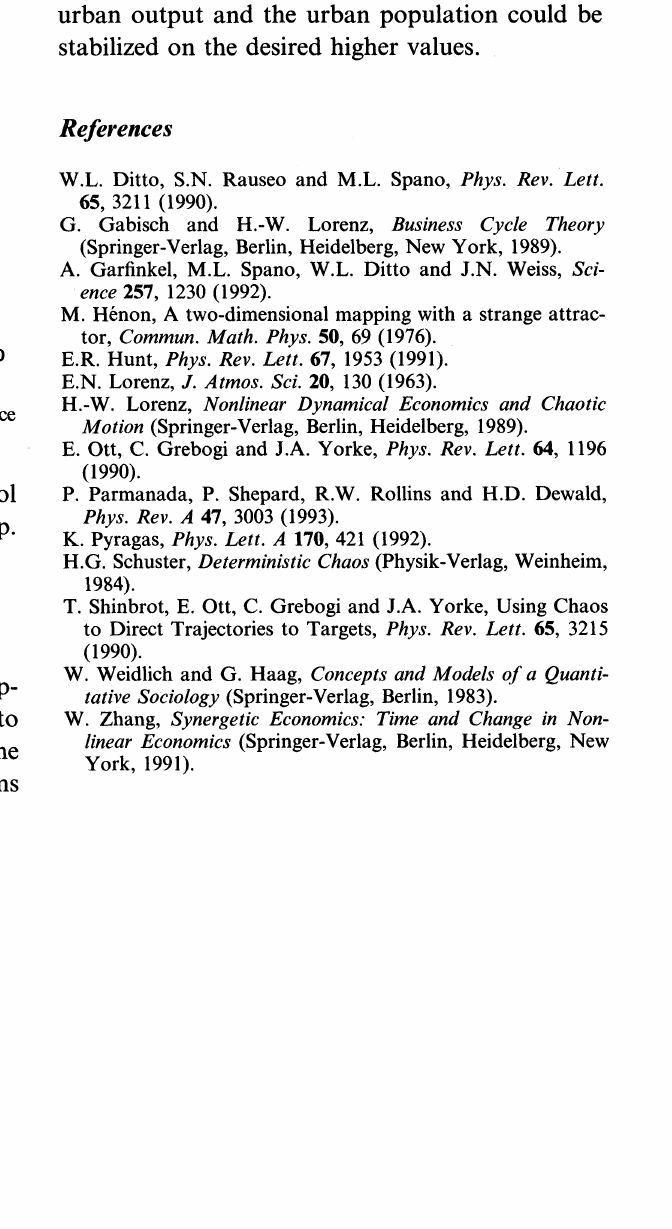
FIGURE 8 The projection of H6non attractor into one di- mension. The mechanism of stabilization starts at n 1200.